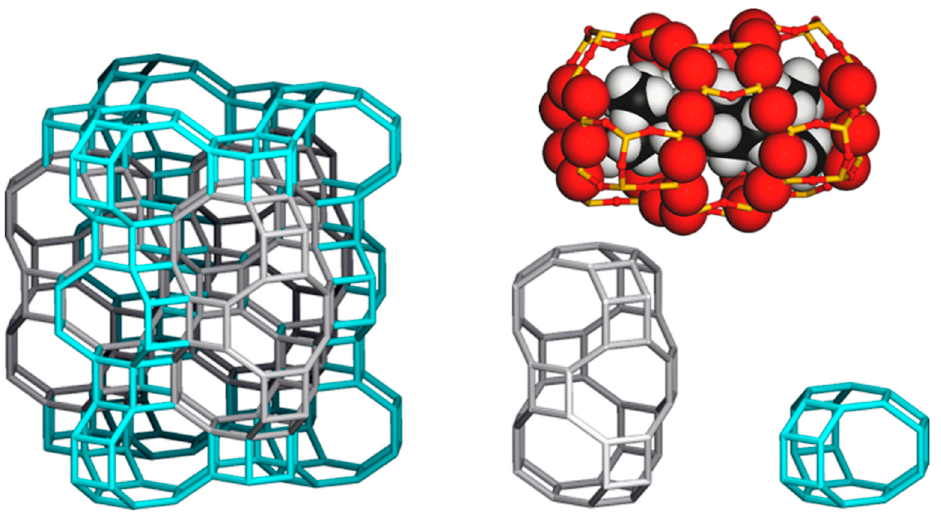
Figure 6. AFX framework composed of two cage structures of aft (gray lines) and gme (green lines). The cartoon shows that one TEBOP 2+ cation occupies one aft cage.